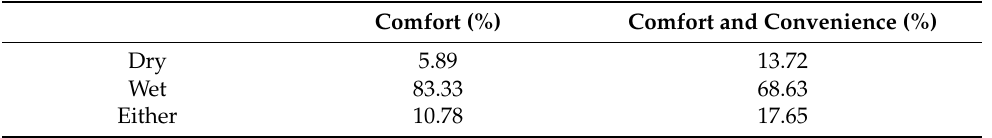
Table 2. Participants’ preference for headbands.